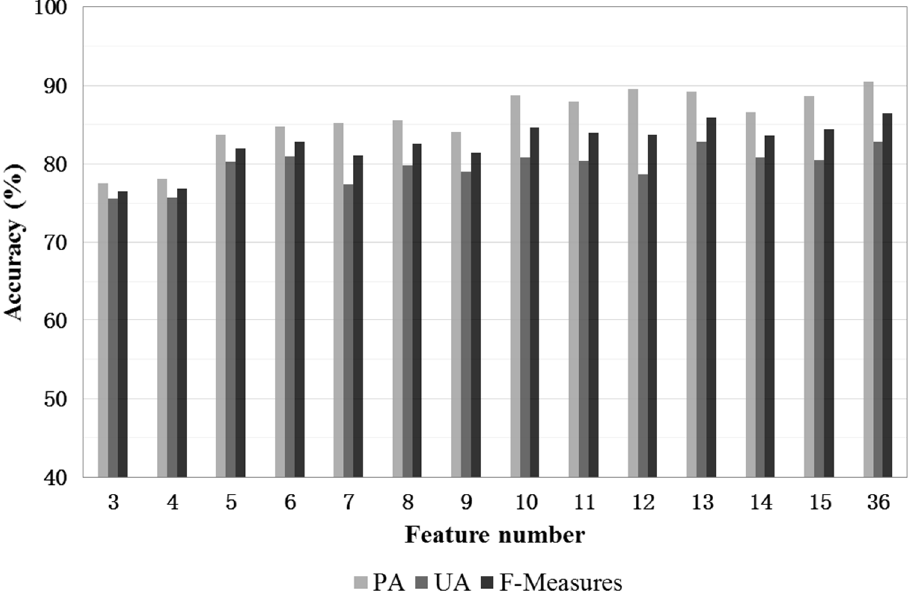
Figure 10. Evolution of classification accuracy related to the number of selected variables in Ansai.